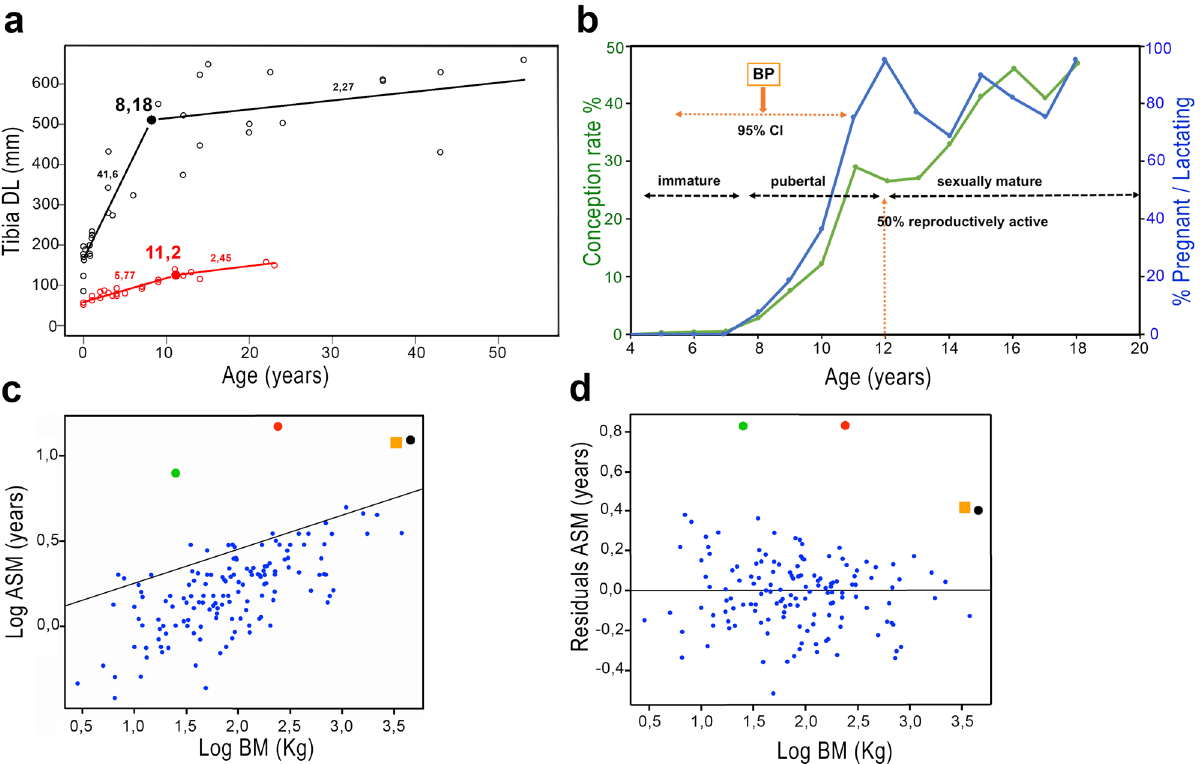
Figure 3. Inference of ASM in P. falconeri . ( a ) Piecewise regressions of tibia diaphyseal lengths (DL) against age (years) in L. africana and P. falconeri . Open black circles and black regression line represent L. africana ; large black dot: break point (BP) with its value; open red circles and red regression line correspond to P. falconeri ; large red dot: break point (BP) with its value; slopes of regressions are placed over the lines for each taxon (Table 2). ( b ) Ontogeny of the reproductive phases of L. africana , shown as age-specific conception rates and reproductive activity for a sample of 905 L. africana cows shot in the Krüger National Park (South Africa) between 1970 and 1974 34 , signaling the reproductive ontogenetic phases. Horizontal bar in the upper left corner indicates the timing of the break point (BP) obtained from DL of the tibia with the 95% confidence intervals (See “Materials and methods”; Supplementary material 6). ( c ) ASM: scatterplot of phylogenetic generalized least square regressions (PGLS) of log ASM (y) against body mass (x) for extant ungulates (n = 145) and elephants (Data base from AnAge 35 ). Results of PGLS regression in Supplementary material 8. Blue dots: ungulates; red dot: P. falconeri ; green dot: Myotragus balearicus 36 ; black dot: Elephas maximus ; orange square: L. africana ; ( d ) Residuals of ASM in ungulates from PGLS regression of ASM against body mass. Blue dots: ungulates; Red dot: P. falconeri ; Green dot: Myotragus balearicus 36 ; Black dot: Elephas maximus ; orange square: Loxodonta africana (Data from AnAge Data base 35